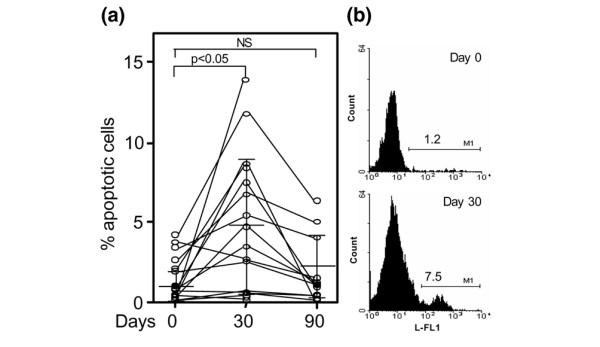
Effect of Rituximab therapy on the apoptosis of peripheral blood mononuclear cells (PBMNCs) in patients with systemic lupus erythematosus. Freshly isolated PBMNCs from patients with systemic lupus erythematosus were fixed, stained using the TUNEL technique, and analyzed by flow cytometry before (day 0), and at days 30 and 90 of Rituximab therapy. Data from all samples studied are shown in (a), and representative histograms of flow cytometry analysis are shown in (b). The arithmetic mean is indicated with a horizontal line and the standard deviation with a vertical line. Numbers in (b) correspond to the percent of positive cells.